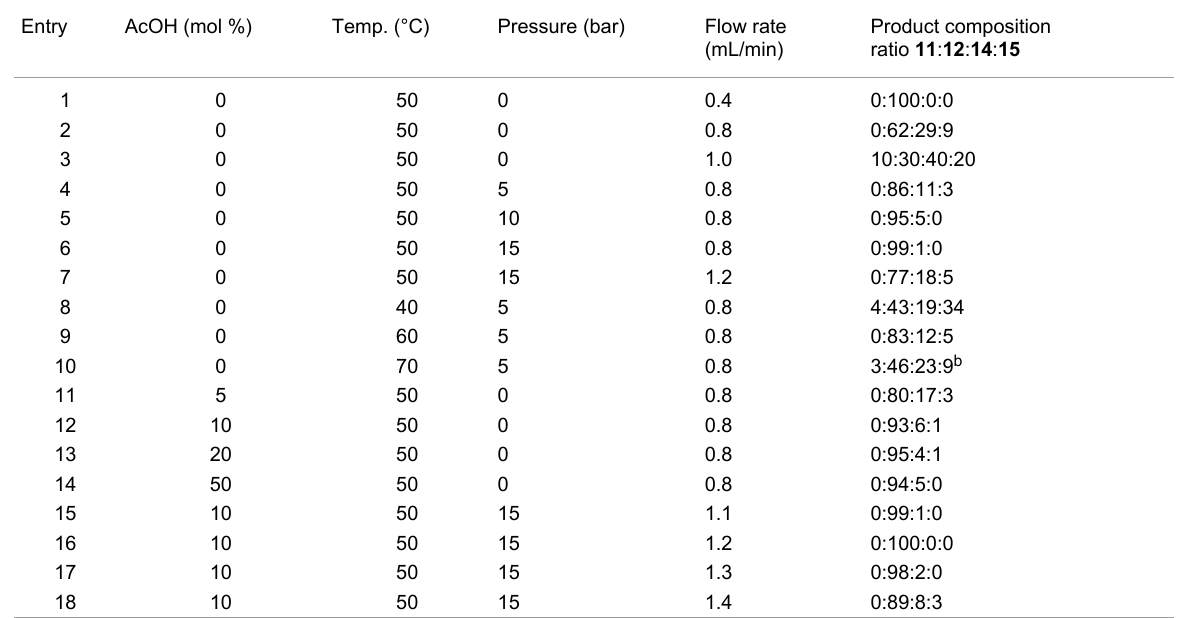
Table 2: Selected optimisation experiments for reductive cyclisation to compound 12 . a Entry AcOH (mol %) Temp. (°C) Pressure (bar) Flow rate